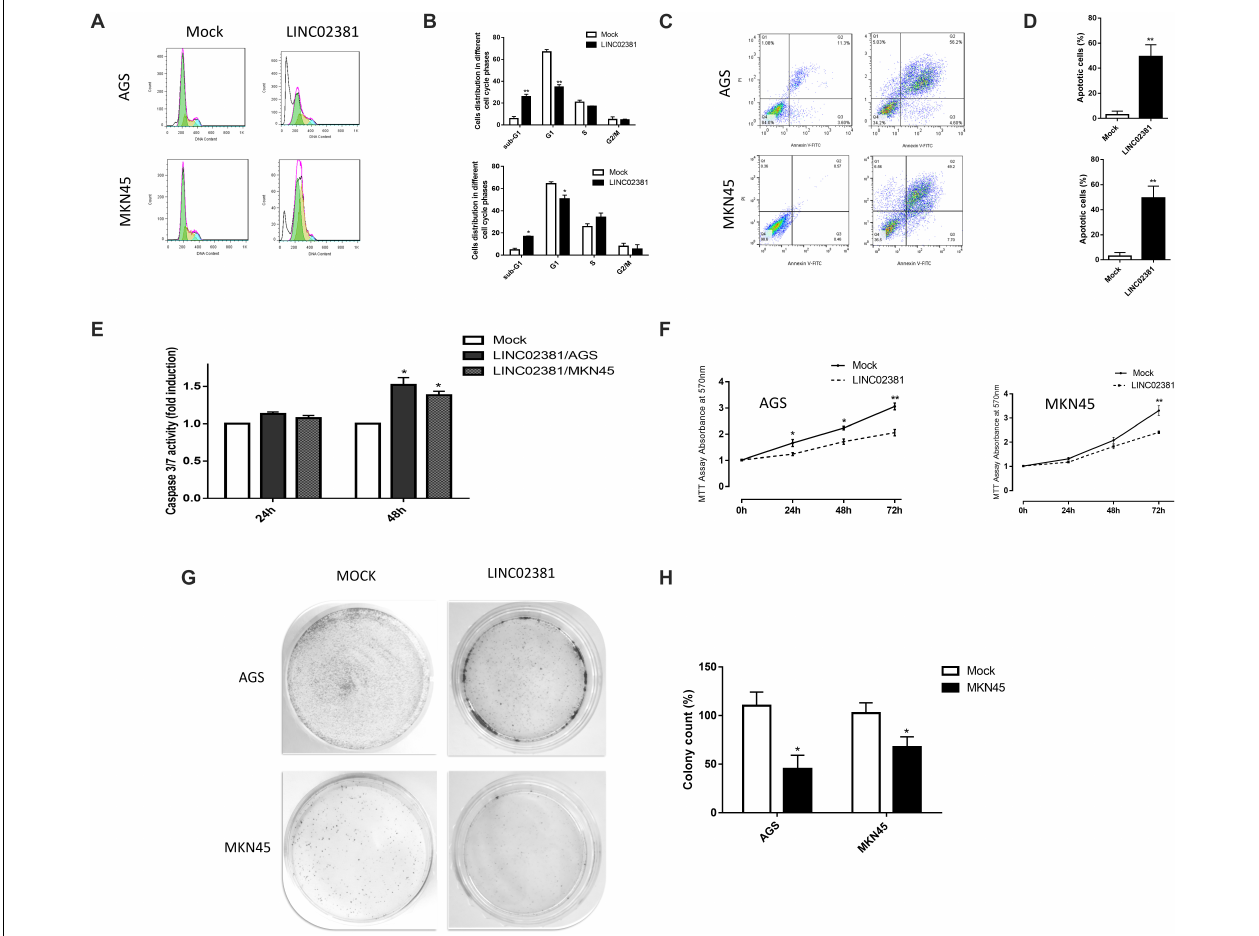
FIGURE 5 | LINC02381 overexpression effects on the cell cycle, apoptosis, proliferation and colony formation in gastric cells. (A) Shows PI staining flow cytometry analysis of AGS and MKN45 cells transfected with empty (mock) vector or the vector which ensured LINC02381 overexpression. (B) Shows percentage of the cells in each phase of cell cycle, following the LINC02381 overexpression. Sub-G1 cell proportion has been increased and S phase proportion has been decreased as a result of LINC02381 overexpression in both cell lines. (C) Representative dot blots of Annexin flow cytometry to assess cell apoptosis. Data indicate that early and late apoptosis have been increased following the LINC02381 overexpression in both cell lines. (D) Apoptotic cell percentages of total cells by Annexin flow cytometry. Data represent the mean ± SEM from two independent experiments. * P < 0.05, ** P < 0.01. (E) Caspase 3/7 activity measurement in AGS and MKN45 cells 24 and 48 h post-transfection showed increased the caspase activity in LINC02381 transfected cells. (F) MTT assay results show LINC02381 overexpression effect on AGS and MKN45 cells survival rate, 24, 48 and 72 hours post transfection. Results were compared to the cells that mock control vector has been transfected. Graphs show that LINC02381 overexpression has reduced transfected cell proliferation/survival. (G) Represents colony formation rate of the AGS and MKN45 cells transfected with either the vector overexpressing LINC02381, or the mock control vector. Colony formation has been drastically reduced under LINC02381